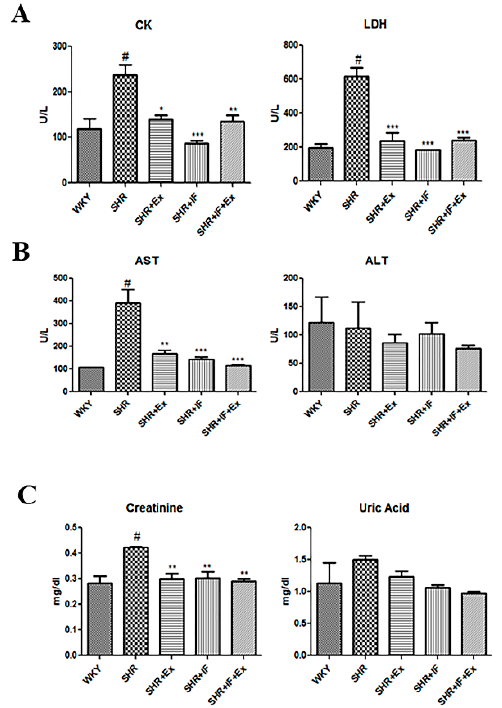
Figure 2. Effect of IF peptide and exercise on heart, liver, and kidney function markers. ( A ) Creatine kinase (CK) and lactate dehydrogenase (LDH). ( B ) Aspartate transaminase (AST) and alanine transaminase (ALT). ( C ) Creatinine and uric acid. n = 8, # p < 0.01 compared to WKY, * p < 0.05, ** p < 0.01, and *** p < 0.001 compared to SHR.